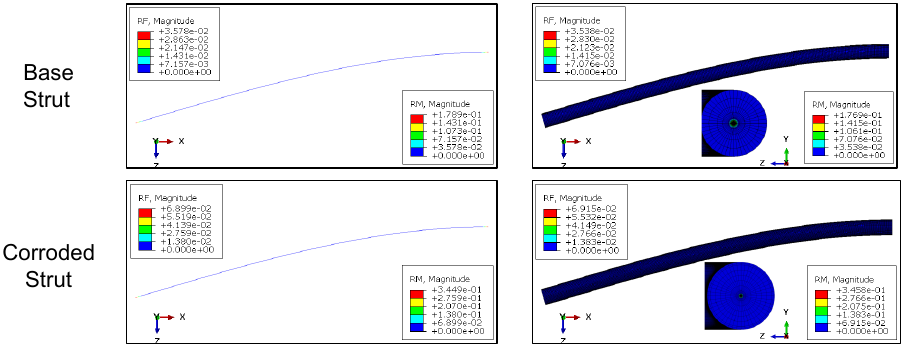
Figure 9. Reaction force (RF) comparison of modeling approaches for base and corroded strut under axial compression; ( left ) beam elements, ( right ) solid elements.